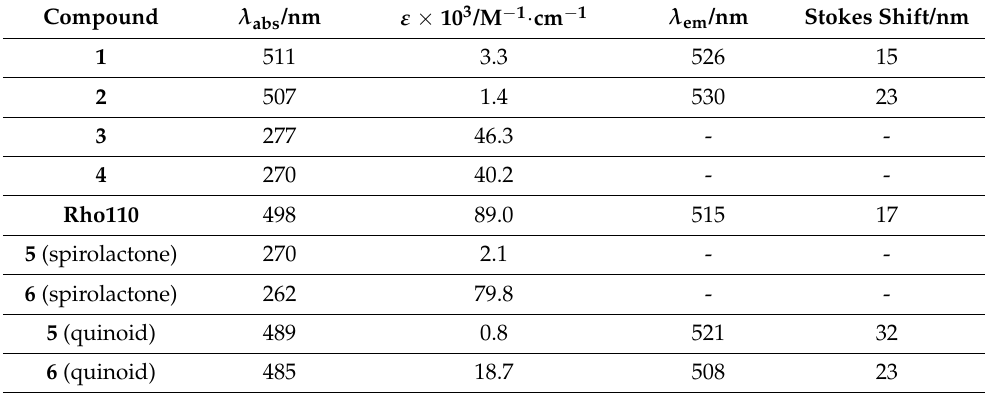
Table 1. Photophysical properties of Rho110 , compounds 1–4 and functionalized derivatives 5 and 6 ( λ of absorption and emission and molar extinction coefficient ( ε ) and Stokes shift) in CH 2 Cl 2 at 25 ◦ C.